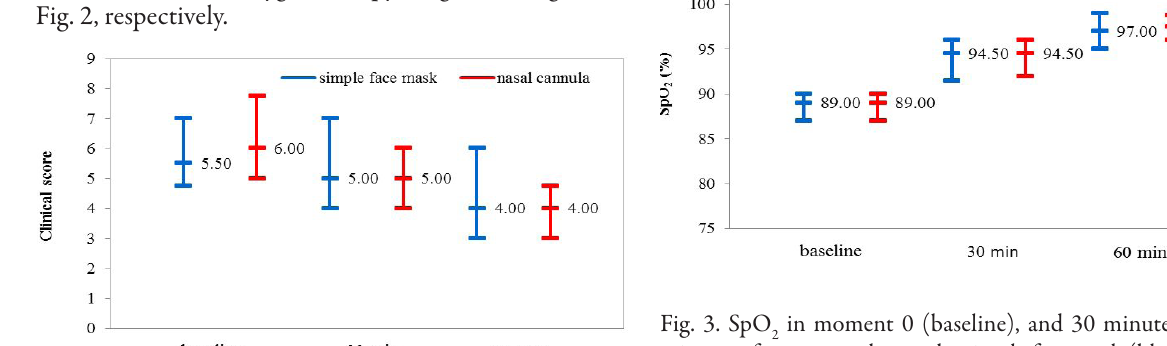
Fig. 3. SpO in moment 0 (baseline), and 30 minutes and 60 2 minutes after oxygen therapy by simple face mask (blue) and by nasal cannula (red). The middle points represent the value of median while the extreme points are the 25 th and 75 th percen- tiles The comparison of SaO and SpO in the subjects who 2 2 were delivered oxygen therapy by simple face mask and na- sal cannula is given in Tab. 3. Tab. 3. Comparison of SaO and SpO in the subjects who were 2 2 delivered oxygen therapy by simple face mask and nasal